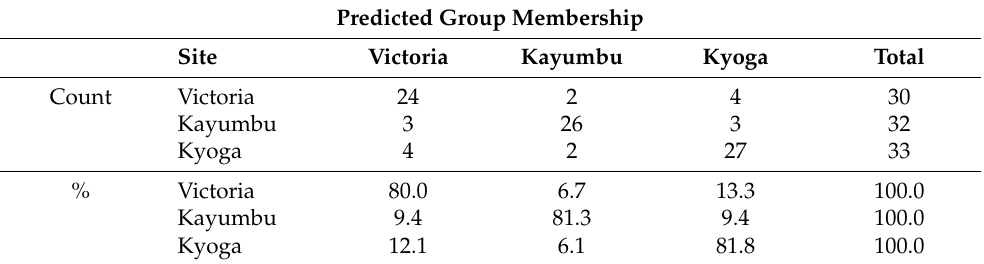
Table 6. Classification Results of Kyanamira sub populations.